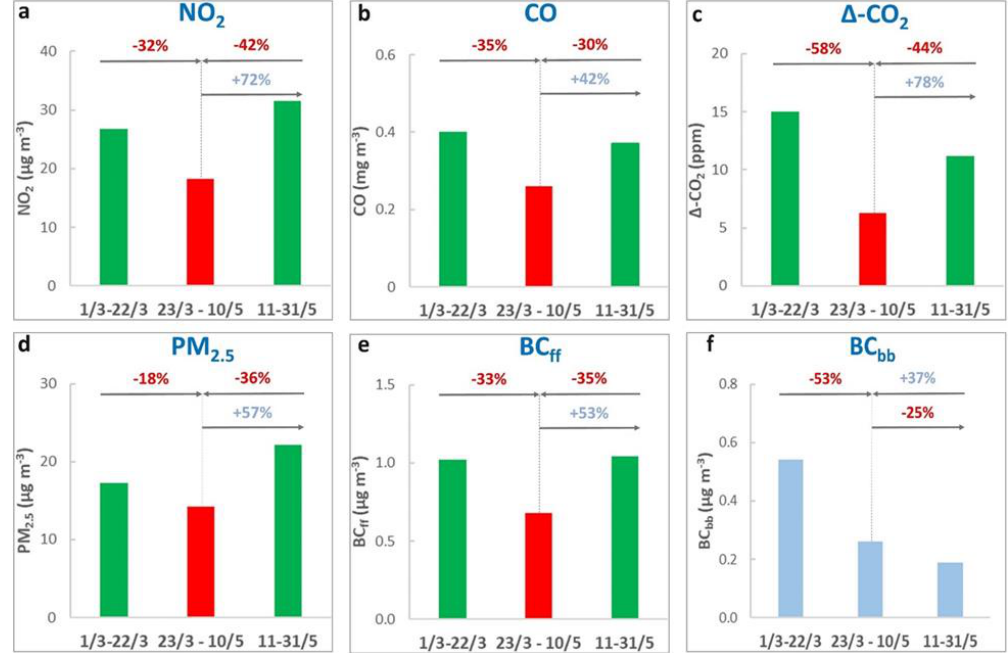
Figure 2. Average concentrations of measured pollutants ( a ): NO 2 , ( b ): CO, ( d ): PM 2.5 , source-specific black carbon components ( e ) : BC ff, ( f ): BC bb and estimated urban enhancement of measured CO 2 ( c ): ∆ –CO 2 ), for pre-lockdown (1–22 March), lockdown (23 March–10 May) and post-lockdown period (11–31 May) in 2020 at the Thissio site in Athens. Percentages indicate the relative changes between the periods.